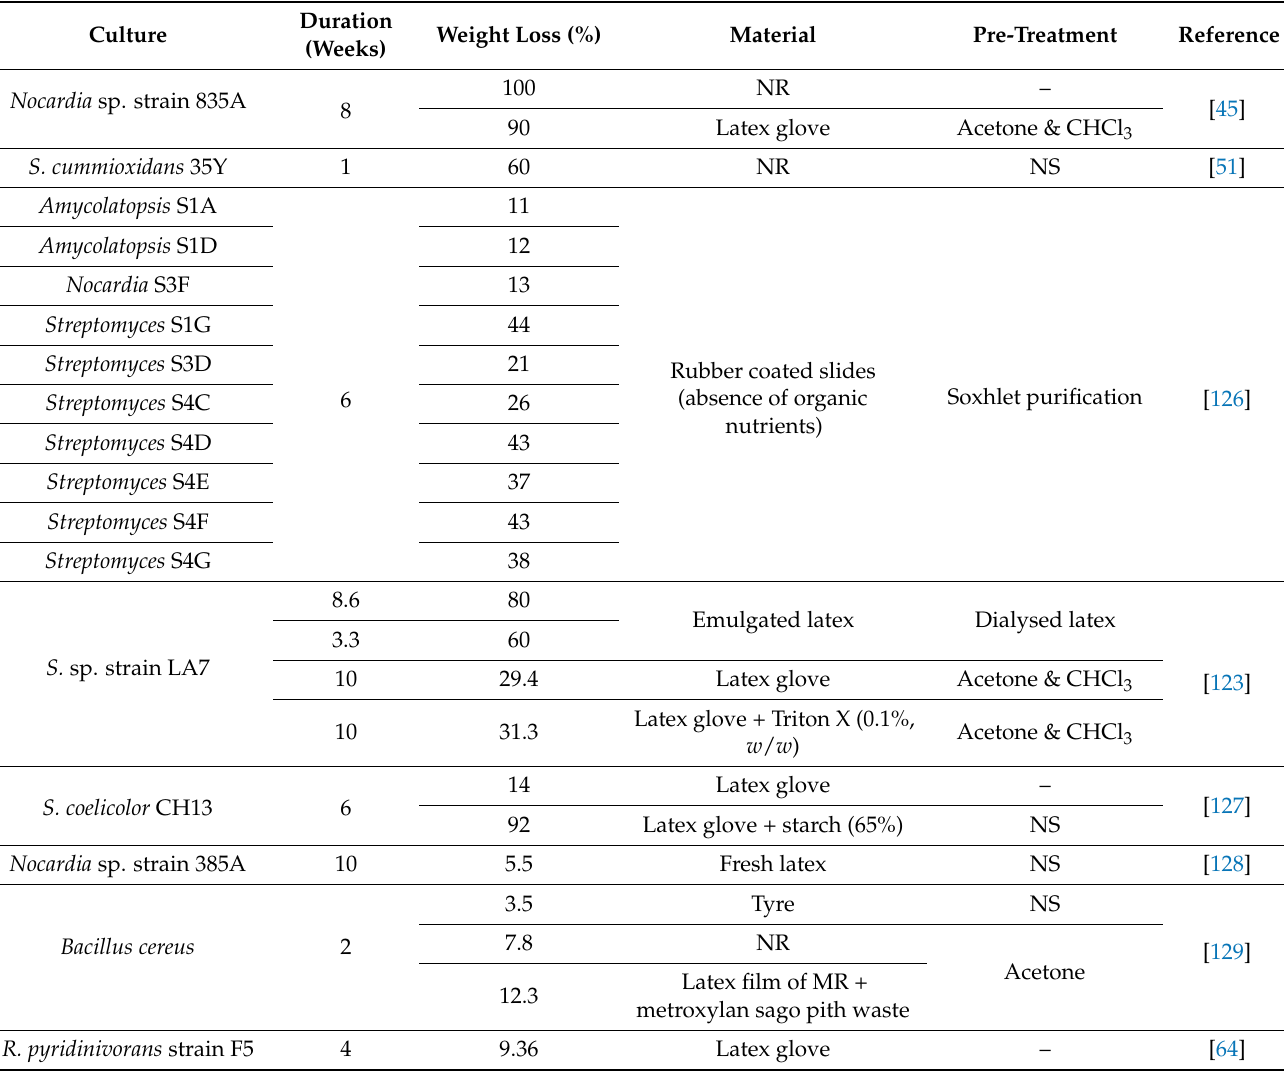
Table 3. Compilation of in vivo culture testing on NR